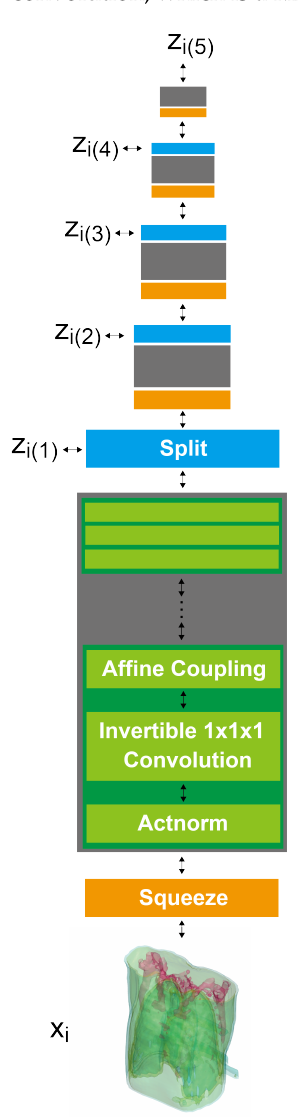
Figure 2. Deep neural network architecture of 3D GLOW. x i represents a 3D CT image vector and z i ( k ) , k = 1, . . . ,5 represent the latent variable vectors in each deep neural network level. We rendered the 3D chest CT image with three iso-surfaces. X2CT-FLOW explores the latent variable vectors z i ( k ) to generate the optimum 3D CT image vector ( x i